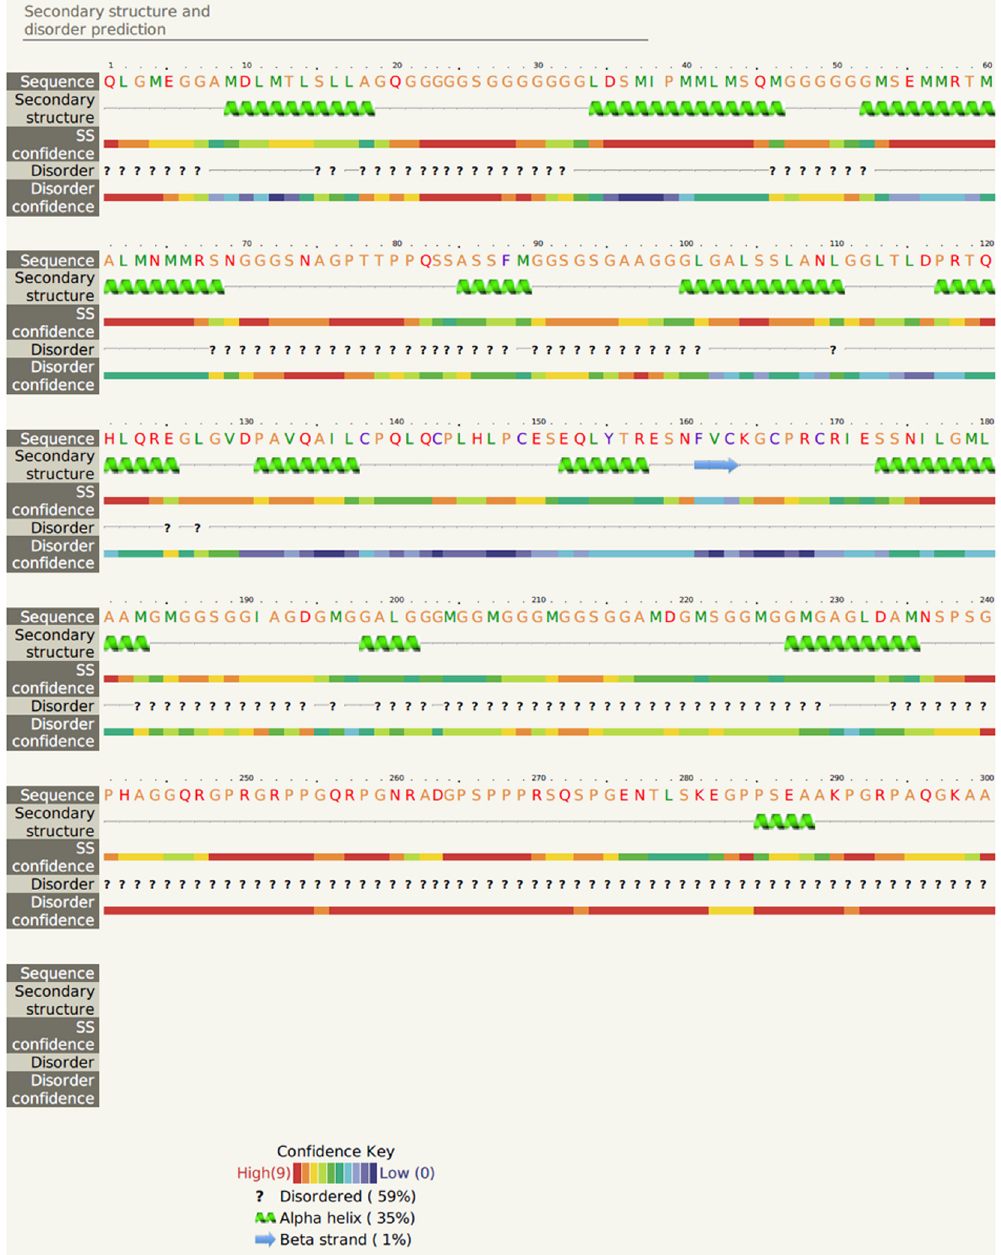
Fig 2. Secondary structure prediction of hic31. Based on the protein sequence of hic22, the secondary structure prediction is performed by Phyre 2 . The amino acids are colored based on the physiochemical properties of the side chains. The regions adopting putative α -helix and β -sheet conformations are represented as green spiral and blue arrow, respectively. The degrees of confidence 0.9 are also indicated by a rainbow color